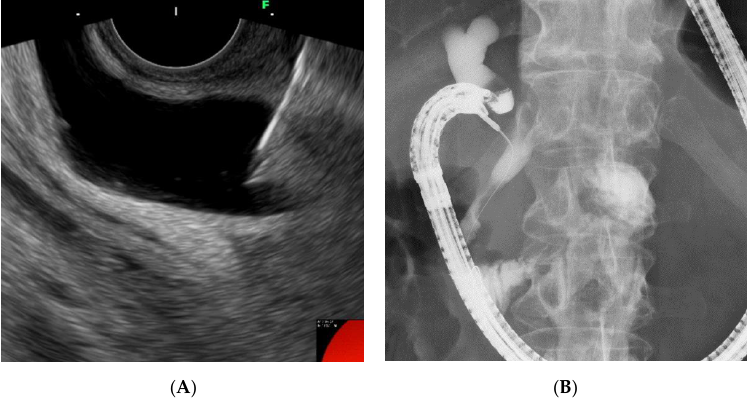
Figure 2. The proximal extrahepatic bile duct/duodenal bulb (PEHBD/D1) route. Endoscopic ultrasound image ( A ) showing needle puncture of the proximal extrahepatic bile duct from the duodenal bulb. Fluoroscopic image ( B ) showing that the guidewire passed through the stricture and papilla into the duodenum.